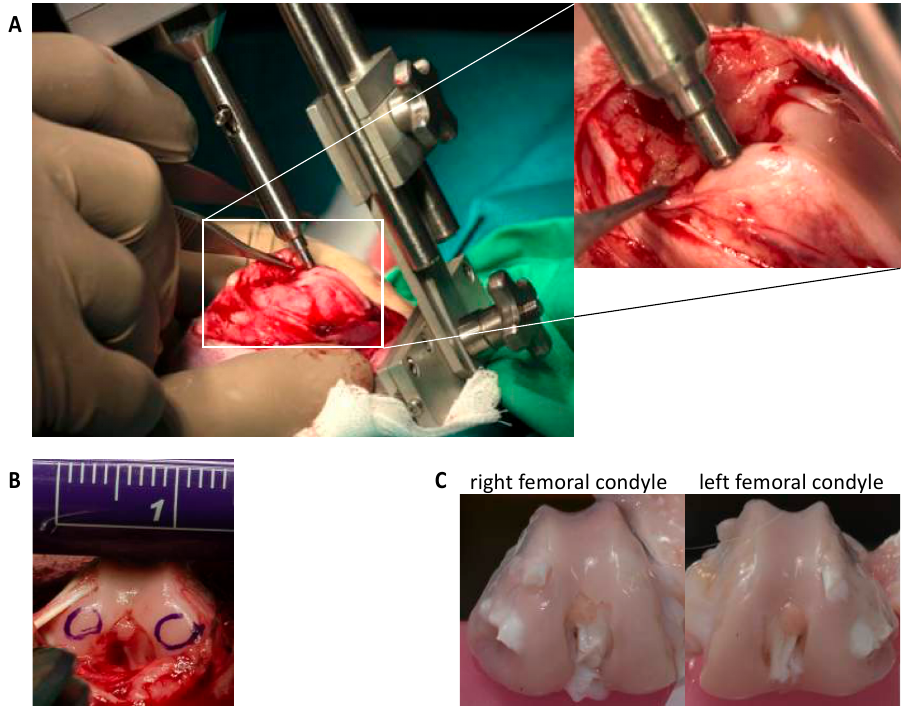
Table 1. Grouping and corresponding treatment scheme of the in vivo experiment. Animal Group A ( n = 5) B ( n = 5) Right knee Trauma (T) + 0.9% NaCl T + NAC Left knee T + BMP7 T + NAC +